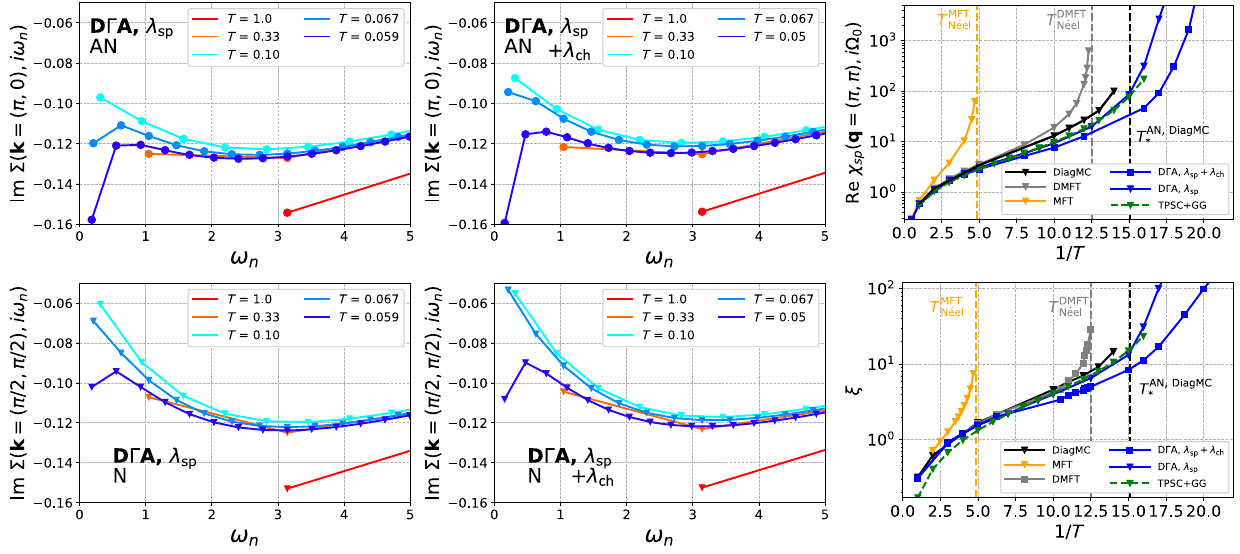
FIG. 35. Results from alternative Moriya correction schemes in ladder D Γ A for various quantities. Note that the lowest temperatures shown for the self-energy do not agree, in order to show the full gap in both